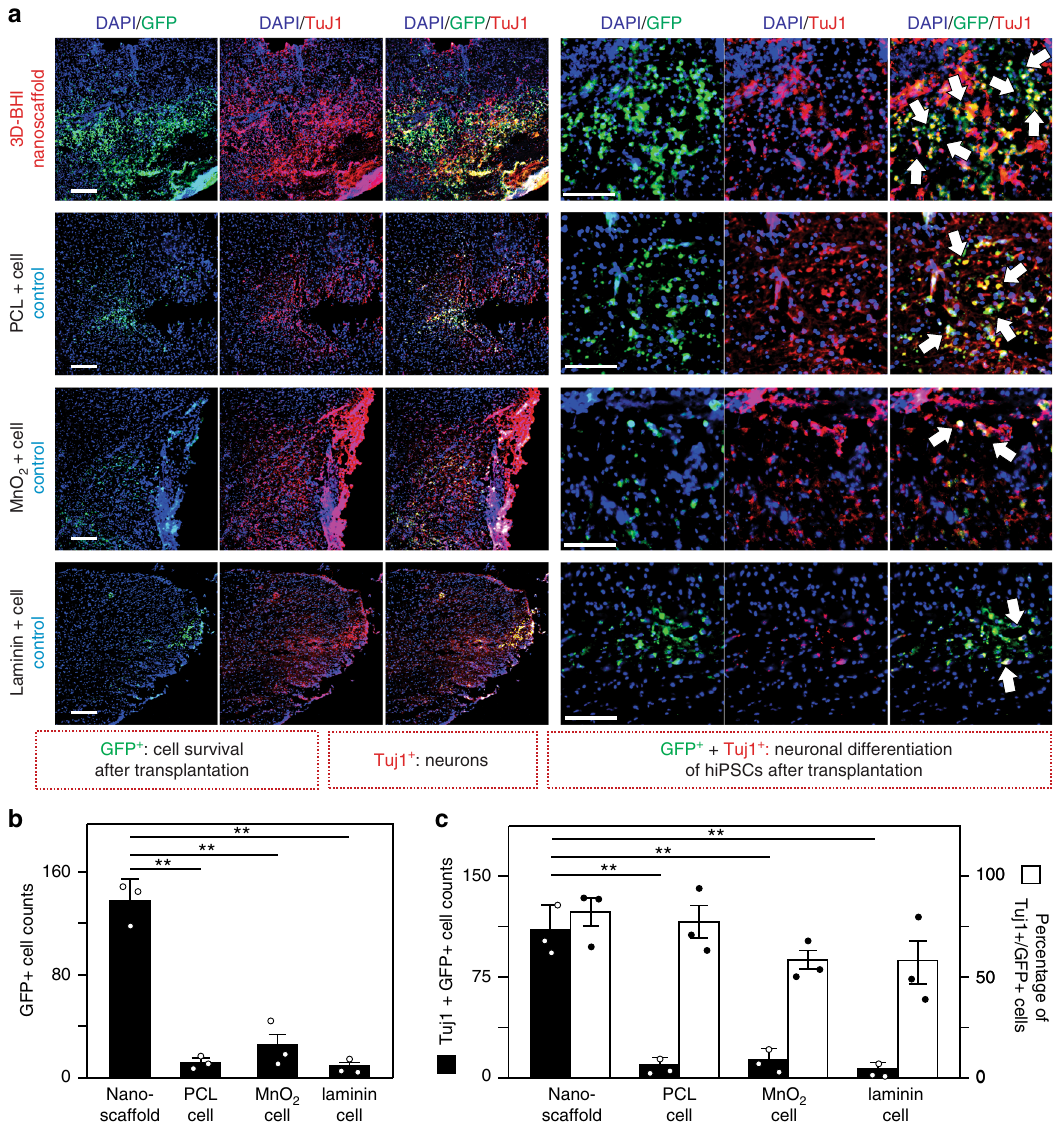
Fig. 7 3D-BHI nanoscaffold enhances survival and neuronal differentiation of hiPSC-NSC-GFP. a Immunohistological staining analysis was performed on tissue slices from 4 different animal groups transplanted with hiPSC-NSC-GFP to determine enhanced cell survival and improved neurogenesis from our 3D-BHI nanoscaffold transplanted condition. All tissue analysis was performed 1-week post transplantation and stained with DAPI (blue) and TuJ1 antibodies (red). Arrows indicate neuronal cells differentiated from hiPSC-NSC-GFP (identi fi ed by TuJ1 + /GFP + cells). b By quantifying the number of remaining GFP + cells, the ability of 3D-BHI nanoscaffold to retain the signi fi cant higher amount of cells after transplantation was demonstrated by comparing to other cell transplantation groups. c Improved cell transplantation by our nanoscaffold can be further evidenced by an increased neuronal cell population and a higher percentage of neuronal cells in GFP + cells (area = 1 mm 2 ). This is consistent with Supplementary Fig. 20, where co-labeling of GFP + /TuJ1 + and GFP + /GFAP + nearby the injured sites suggest most of the transplanted hiPSC-NSC-GFP become neuronal cells but not astroglial cells. Scale bars: 100 μ m. Error bars represent mean ± s.d.; n = 3, ** P < 0.01 by one-way ANOVA with Tukey post-hoc